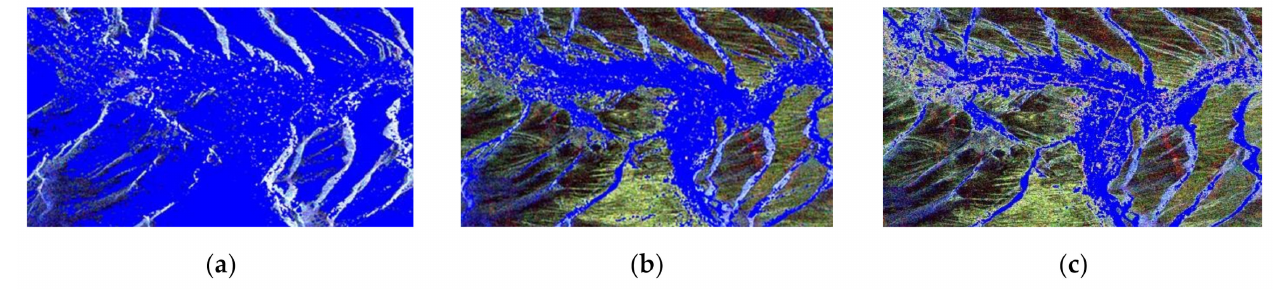
Figure 25. The results of non-building area removal in Yushu with different methods: ( a ) the H − α method; ( b ) the H − α − wishart classification method; ( c ) the proposed method.